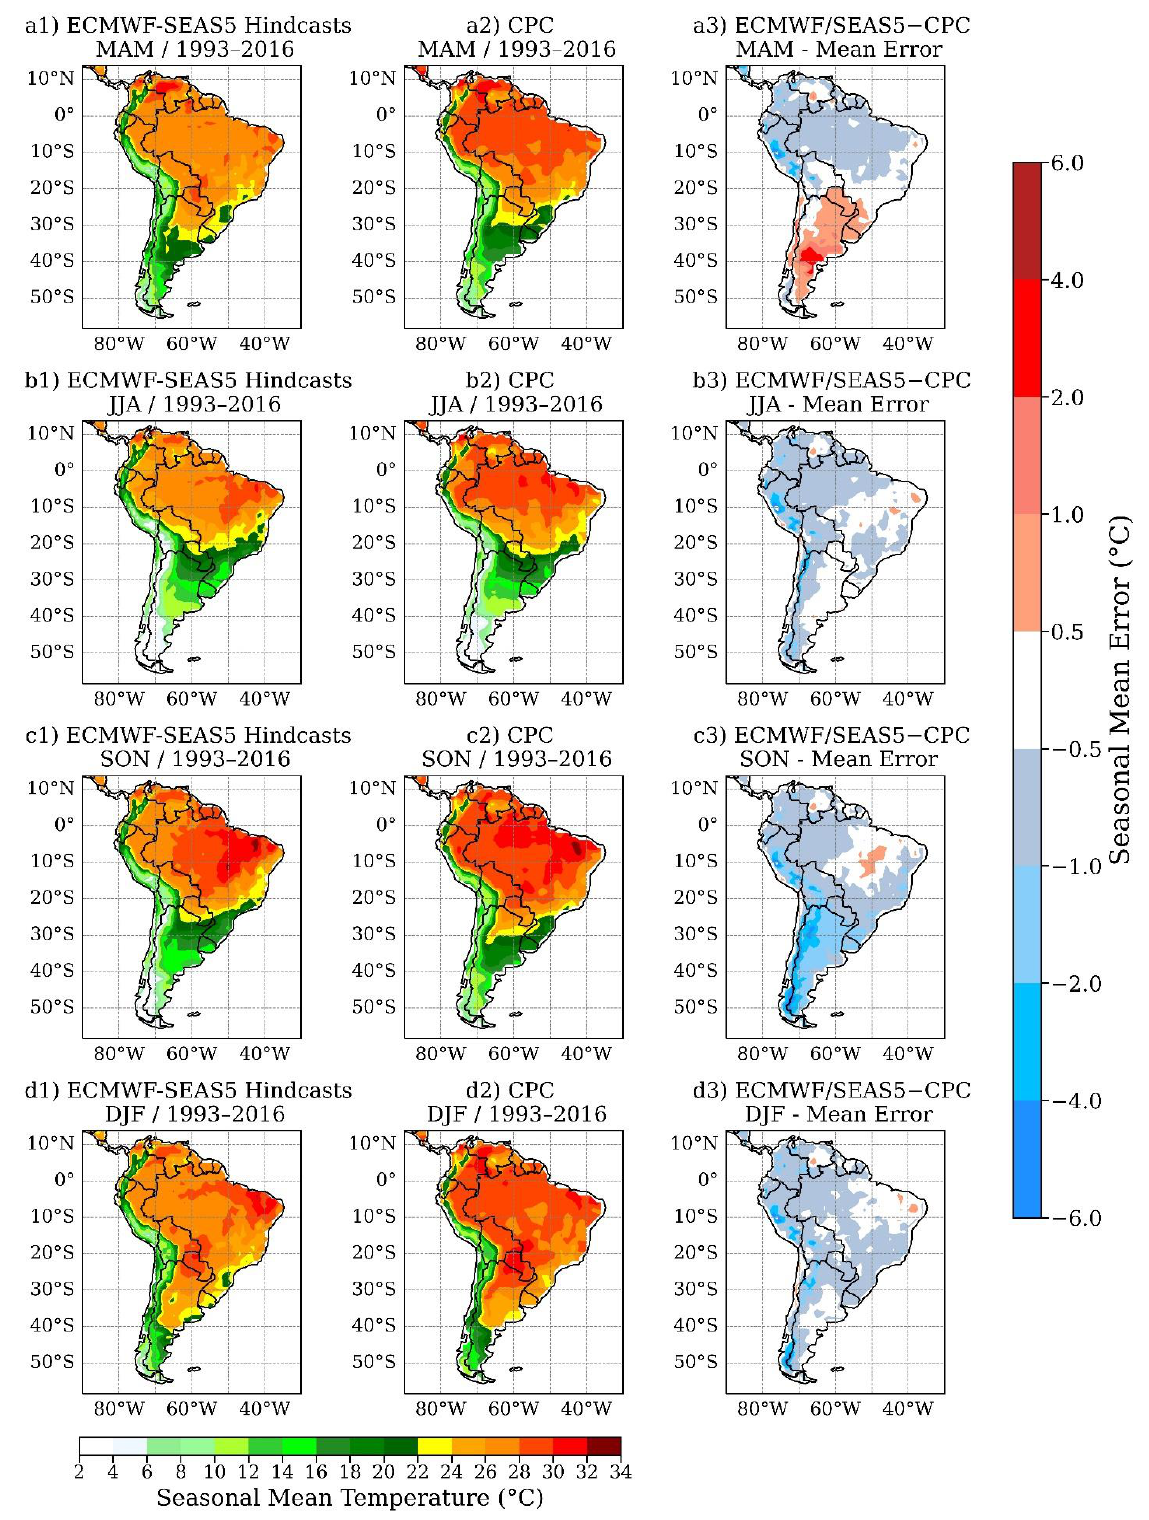
Figure 2. Left column : seasonal mean 2-m temperature (°C) derived from the ECMWF-SEAS5 hindcasts, averaged for 1993 – 2016 and over the 25 ensemble members for ( a ) MAM, ( b ) JJA, ( c ) SON, and ( d ) DJF. Center column : CPC seasonal mean surface temperature (°C) averaged over 1993 – 2016. Right column : seasonal temperature mean errors ( ◦ C) obtained by the difference between ECMWF- SEAS5 and CPC and averaged over